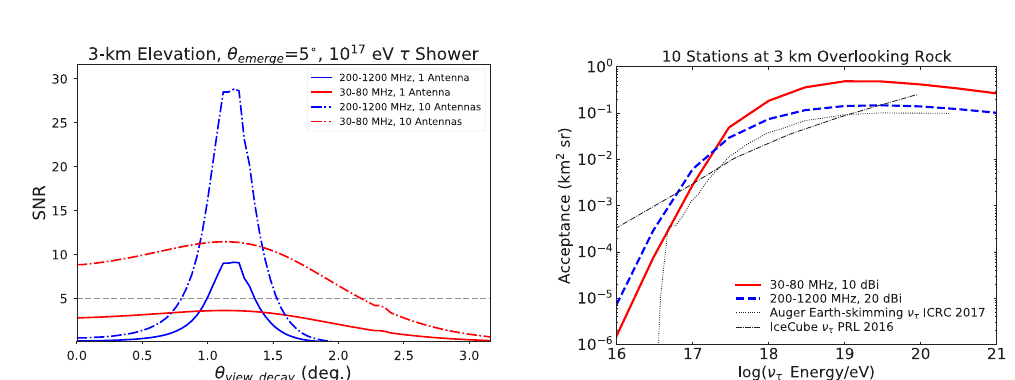
Figure 1. Left : A 10 17 eV τ shower emerging at a 5 ◦ and decaying at the exit point generates a radio beam pattern shown here as the SNR versus θ v ie w, deca y . The radio emission is filtered in the 30-80 MHz (red) and 200-1200 MHz bands (blue) for 1 antenna (solid) and 10 phased antennas (dot-dashed). Right : The acceptance of 10 mountaintop radio detectors to ν τ ’s compared to IceCube’s acceptance to ν τ ’s [5] and the Pierre Auger Observatory’s acceptance to Earth-skimming ν τ ’s